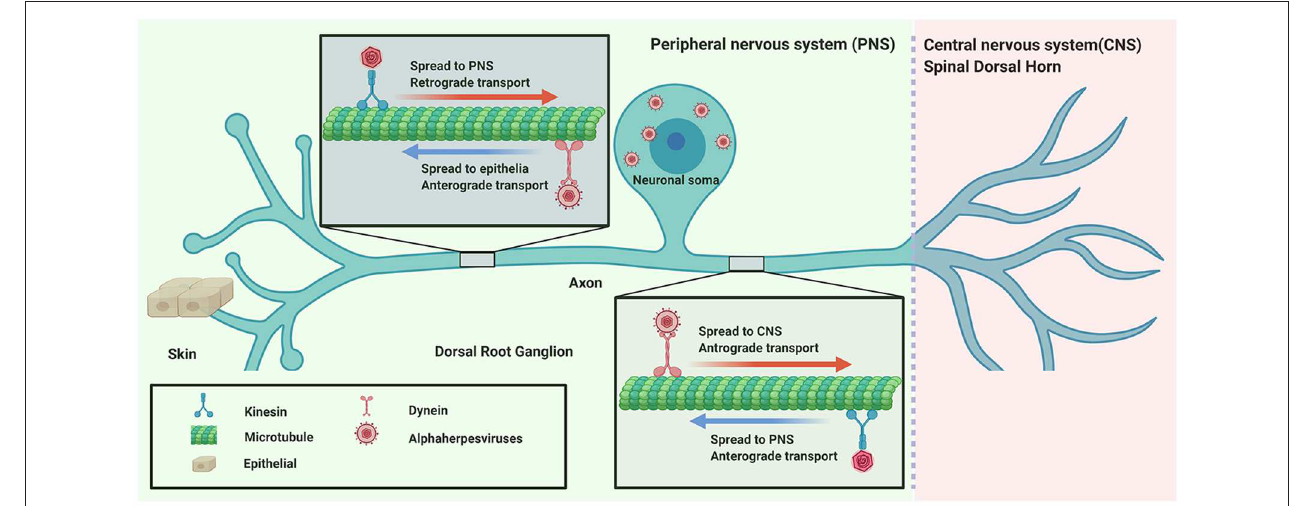
FIGURE 1 | Directional spread of neuroinvasion viruses (alphaherpesviruses) entering the nervous system.